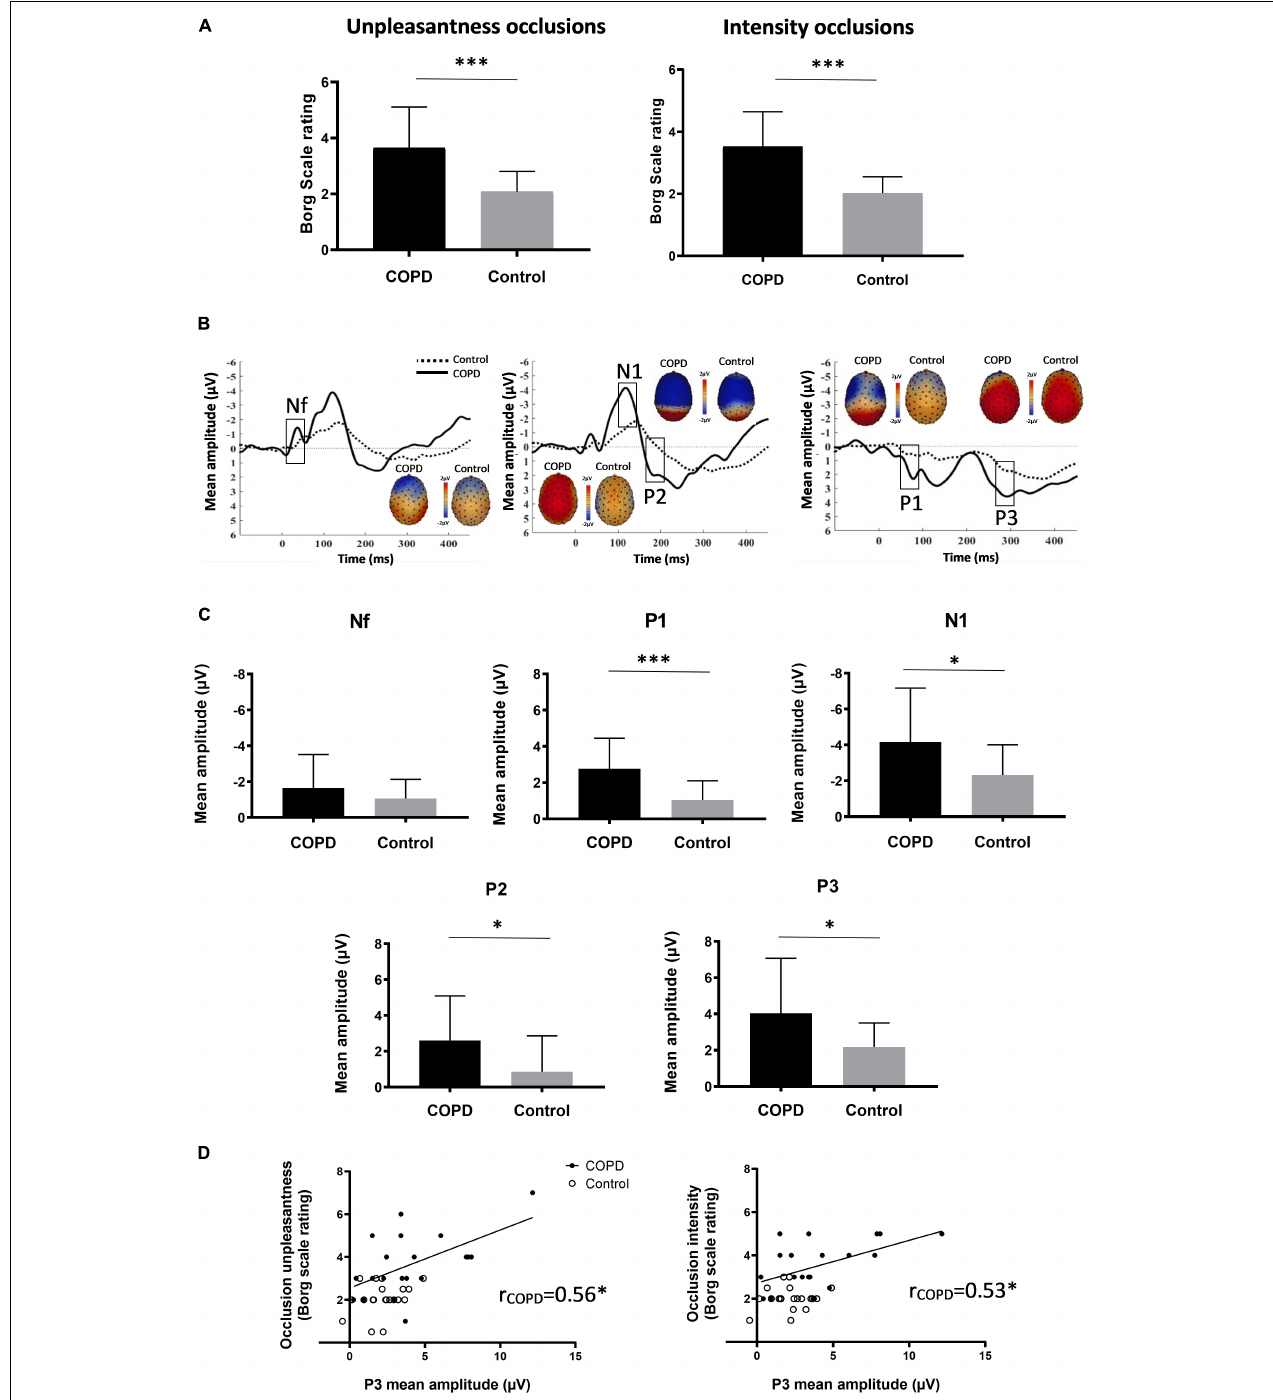
FIGURE 1 | (A) Mean ( ± SD) ratings of occlusion intensity and unpleasantness for COPD patients and control subjects. (B) Averaged waveforms ( µ V) of the respiratory-related evoked potential for COPD patients and control subjects from sensors at frontal (Nf), centro-lateral (N1 & P2), and centro-parietal (P1 & P3) scalp positions. Based on previous reports (von Leupoldt et al., 2011), RREP components were identified as: Nf, negative peak – frontal region (latency: 25–50 ms); P1, positive peak – centro-parietal region (latency: 45–65 ms); N1, negative peak – centro-lateral region (latency: 85–125 ms); P2, positive peak – central region (latency: 160–230 ms); P3, positive peak – centro-parietal region (latency: 250–350 ms). RREP components and respective topographical areas are indicated on the figure. (C) Mean ( ± SD) amplitudes ( µ V) for RREP components Nf, P1, N1, P2, and P3 for COPD patients and control subjects. Mean amplitudes were calculated around each individual peak using a latency window of ± 10 ms for Nf and P1, and ± 20 ms for N1, P2, and P3. (D) Correlations between mean P3 amplitudes ( µ V) and Borg scale ratings of intensity and unpleasantness for COPD patients. ∗ p < 0.05; ∗∗∗ p < 0.001.